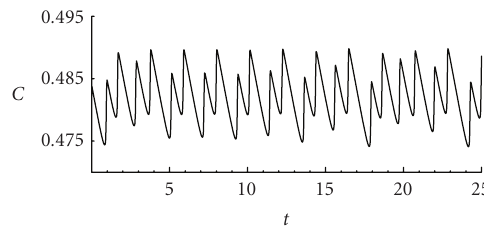
Figure 2.5. Time sequence of calcium concentrations for g K , C = 10 . 8 s − 1 .